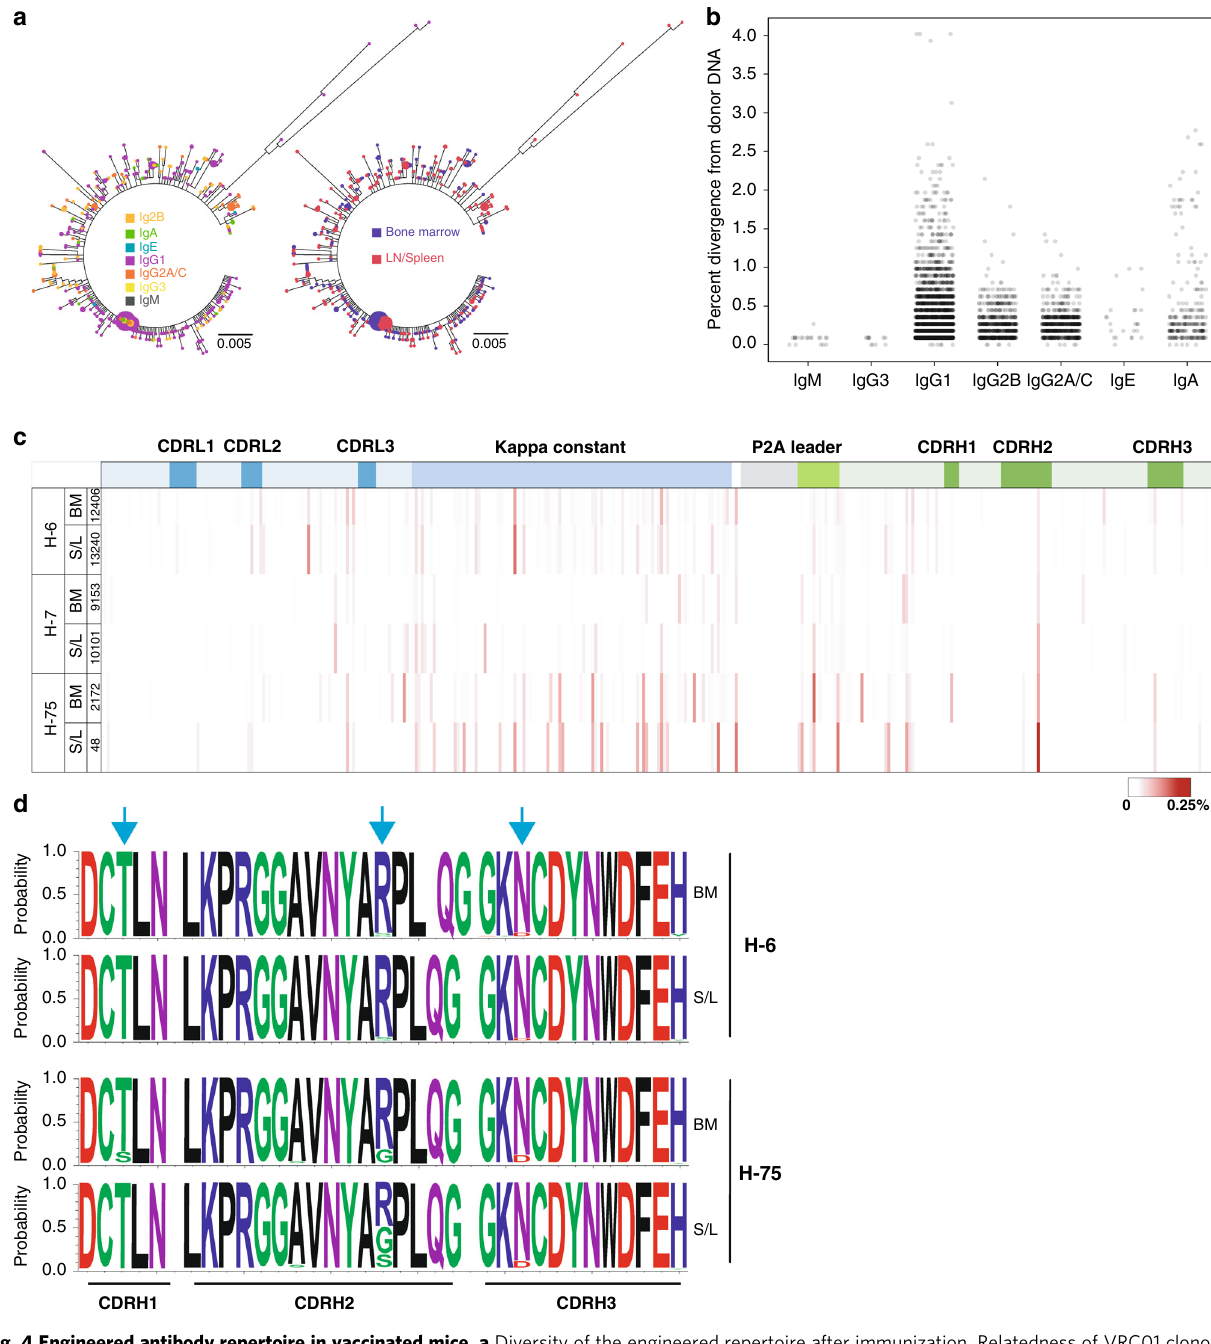
Fig. 4 Engineered antibody repertoire in vaccinated mice. a Diversity of the engineered repertoire after immunization. Relatedness of VRC01 clonotypes by isotype (left), and compartment (right), in one representative animal (H-7) 5 weeks after the fi nal boost. b Somatic hypermutation by isotype. Percent divergence from donor DNA nucleotide sequence is shown for combined engineered repertoires from all compartments and animals sequenced by isotype. Fewer engineered IgM or IgG3 sequences were obtained and these were mostly unmutated (<5% of sequences), while IgG1, G2B, G2A/C, E, and A were signi fi cantly mutated (>68% of sequences, reaching up to 4% mutated) (Supplementary Fig. 6). Fig. S6). c Mutational hotspots in the engineered VRC01 gene. The frequency of amino acid changes at each residue position across the H-targeted VRC01 gene is shown as a percentage of the total sequences obtained for each dataset. Six datasets are shown which are derived from both memory and plasma cell compartments from the three indicated mice. Speci fi c coding changes across the length of the gene are given in Fig. S6 from one representative mouse (H-6). d Antigen-binding properties are diversi fi ed in the engineered repertoire. The fraction of sequences with coding changes from memory (S/L) or plasma cell (BM) compartments are shown as sequence logos for the CDRH regions in the indicated mice. Blue arrows indicate amino acid positions undergoing diversi fi